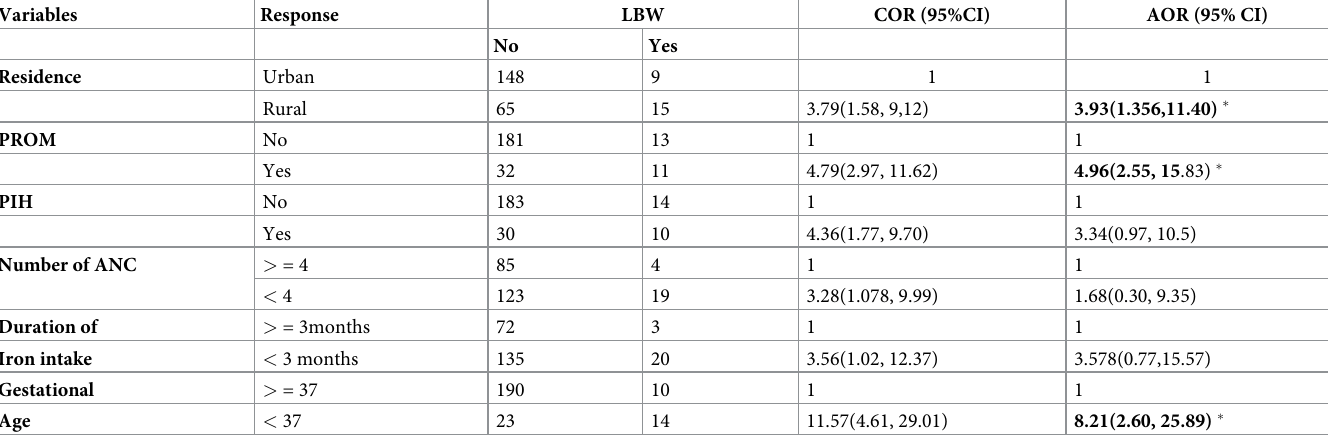
Table 6. Bivariable and multivariable logistic regressions of factors associated with LBW among HIV negative mothers.